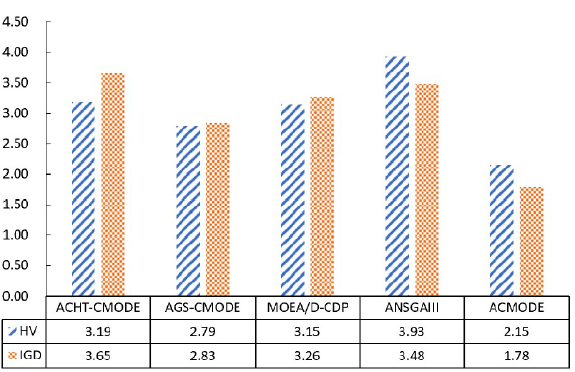
Figure 1. Performance rankings of all comparison algorithms.